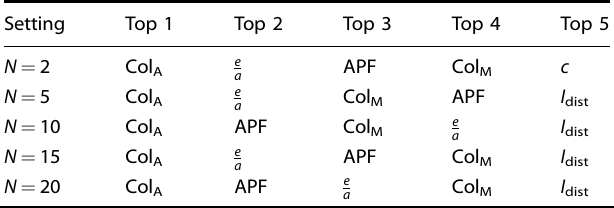
Table 2. The top 5 important factors selected by BART for the maximum bulk modulus K in MAX phases with the initial set of sample size N ∈ {2, 5, 10, 15, 20}.